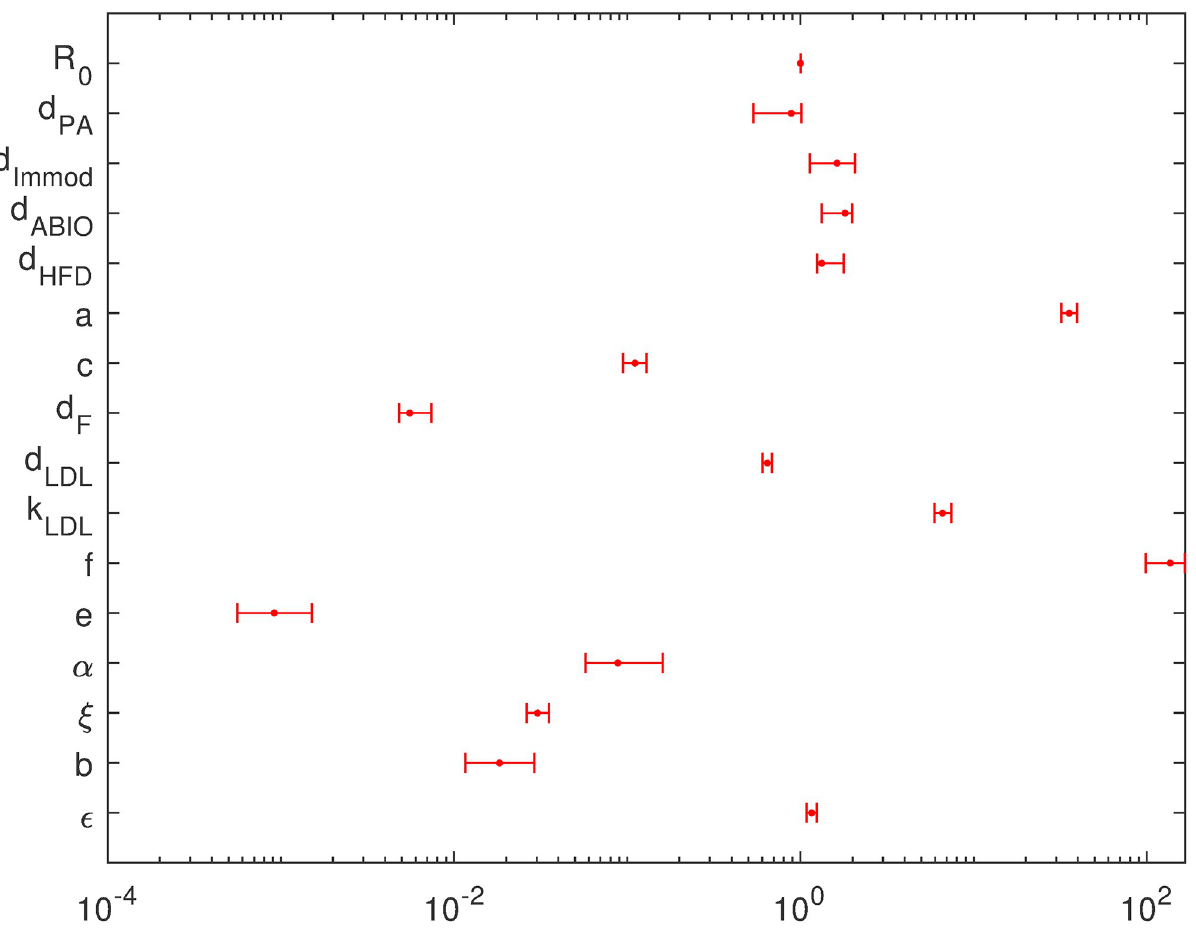
Fig 3. Confidence intervals of parameter estimates. Error bars show model parameters and corresponding 95% confidence intervals.